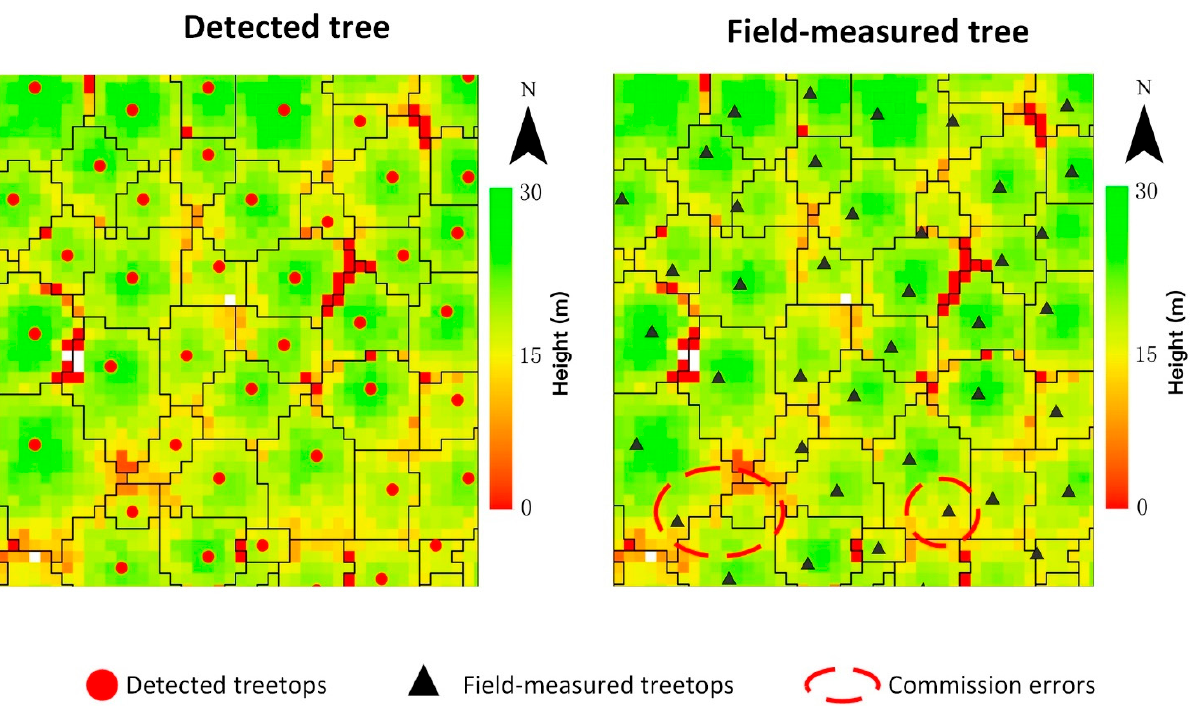
Figure 3. Examples of individual tree delineation. Polygon boundaries represent individual tree crowns. White cells represent no data cells.